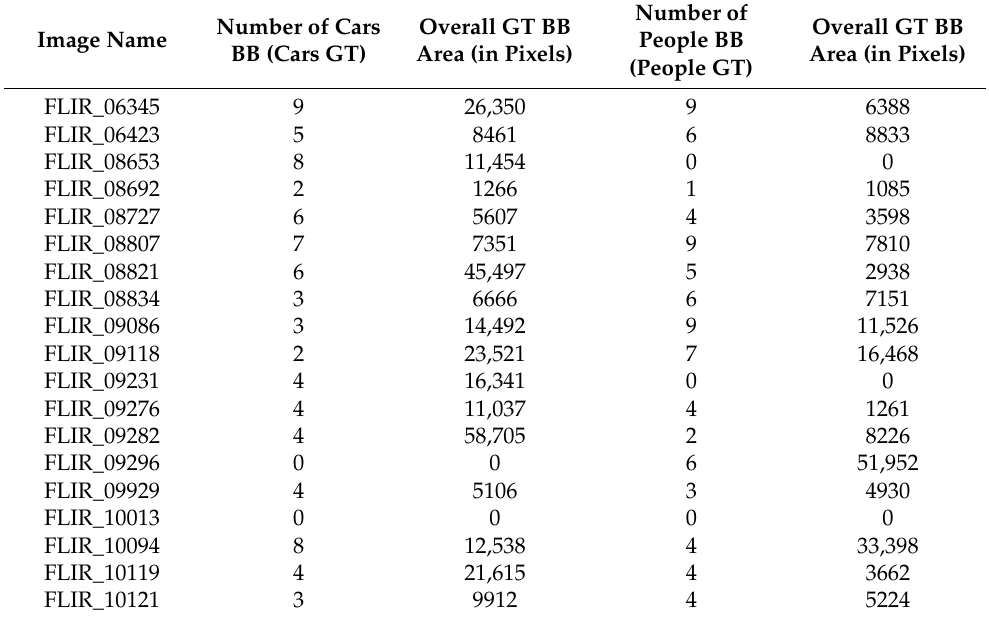
Table A1. Day images, Test DS.